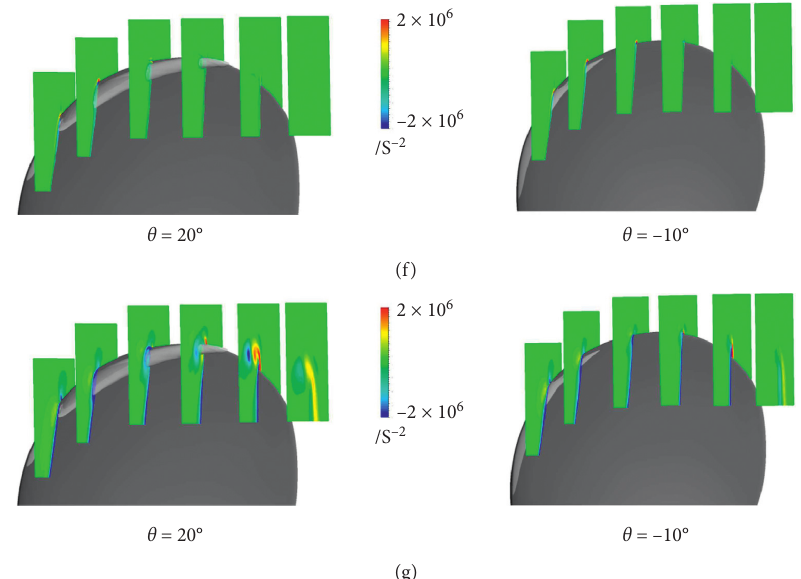
Figure 7: Contours of the predicted vapor volume fraction, relative vorticity, vortex stretching, dilatation, baroclinic torque, and Coriolis force terms on S1 to